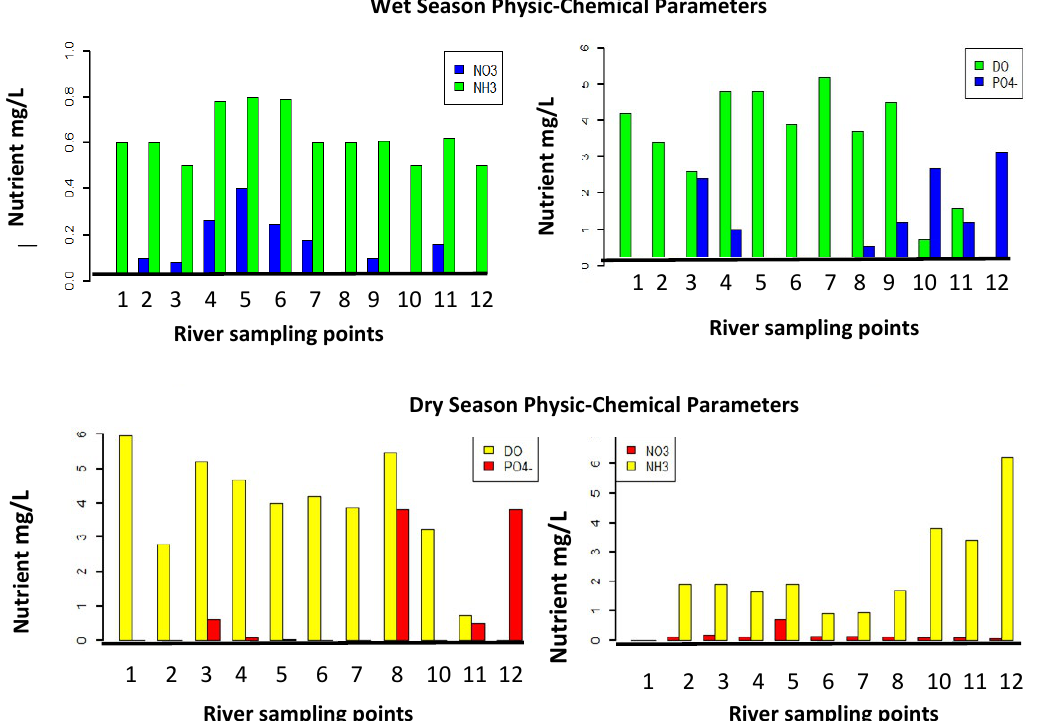
Fig 2: Seasonal variations in water quality along Mukuvisi River, 2018‐2019